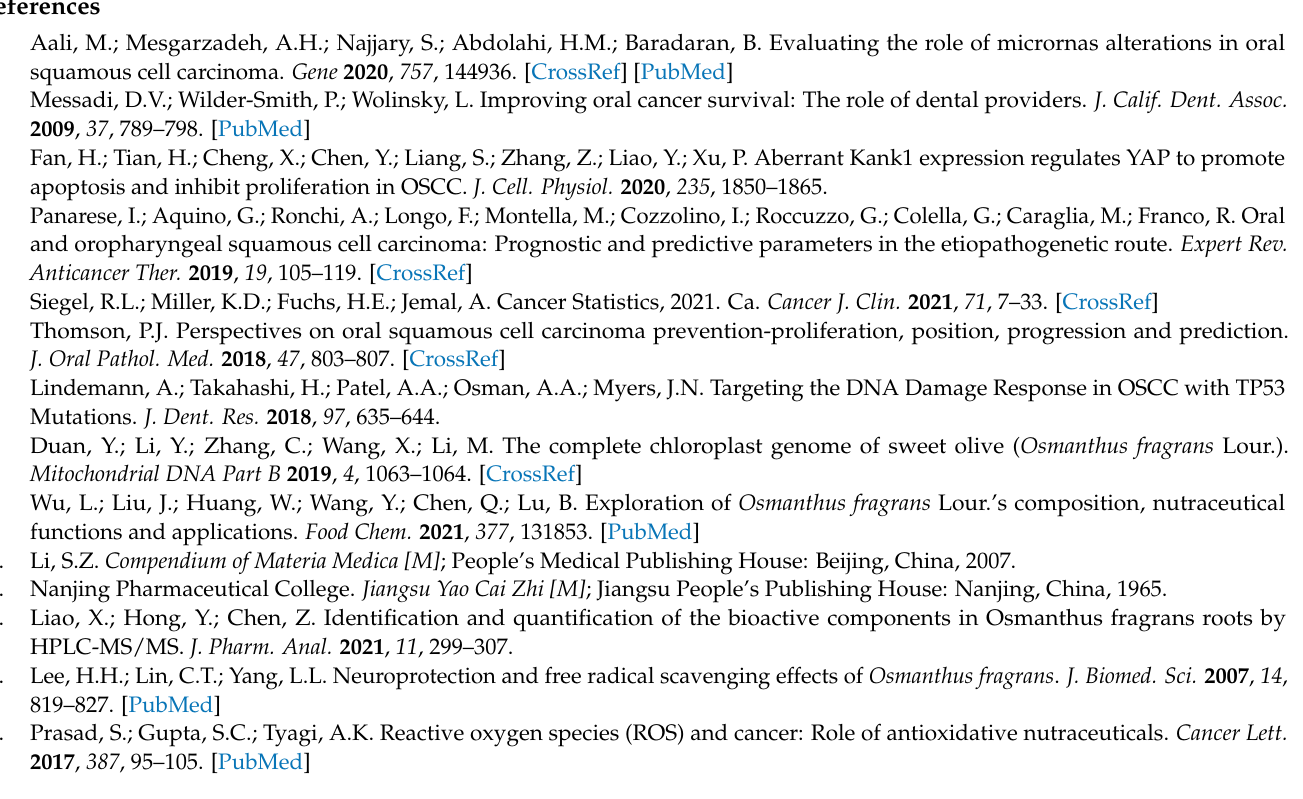
Figure S2: GO enrichment and KEGG pathway analysis represented in a chord plot. A. biologi- cal processes; B. cellular components; C. molecular functions; D. signaling pathways. Figure S3: Component-Target-Pathway. Yellow: Osmanthus fragrans extract; Red: 7 main components; Orange: 54 overlapping genes; Green: Re-lated KEGG pathway. Figure S4: The PPI network analyzed by visualized by Cytoscape software. PPI network of 54 overlapping genes between differential genes of OSCC and osmanthus targeted genes. Figure S5: Molecular docking models of osmanthus extract and AURKA. A. 7 main com-ponents of osmanthus extract were docked with AURKA; B. the affinity of each component with